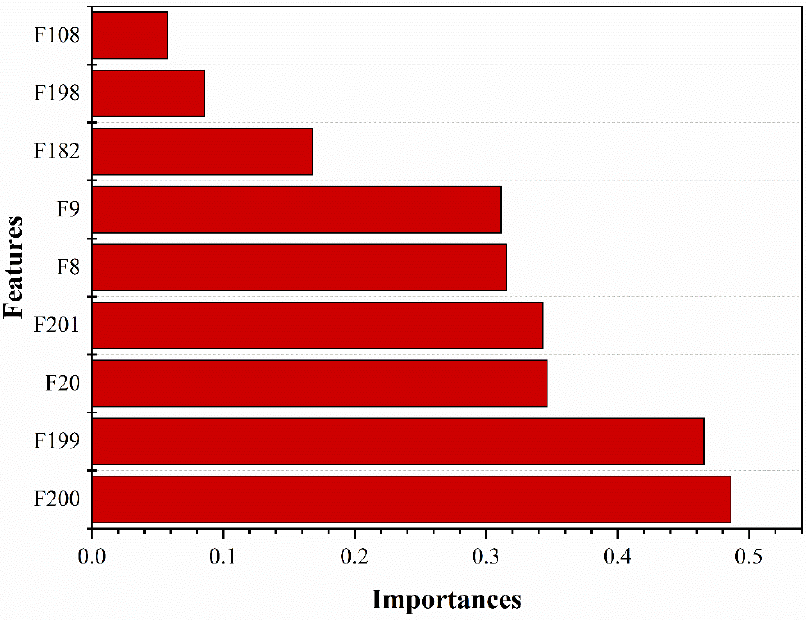
Figure 4. Feature importance ranking.